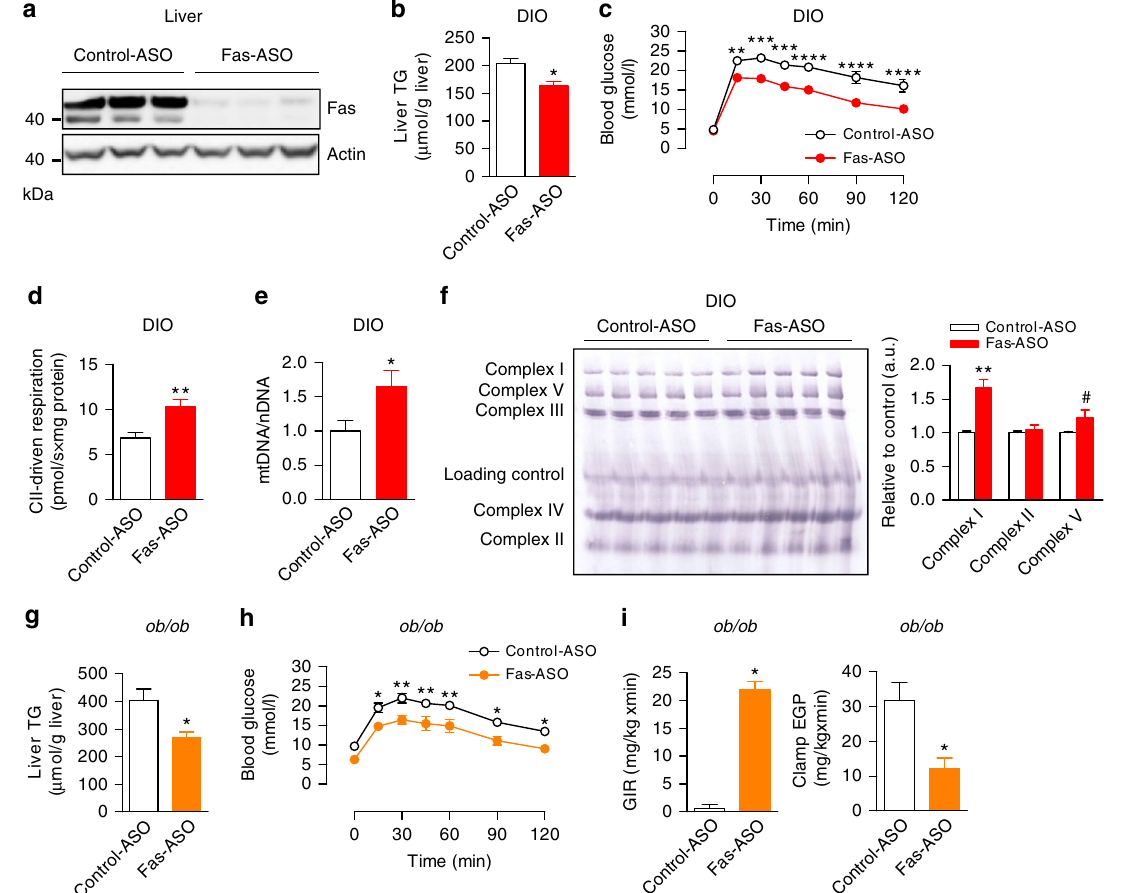
Fig. 5 Pharmacological depletion of Fas in obese mice ameliorates metabolic dysregulation and mitochondrial function. C57BL/6J mice on HFD for 20 weeks received either antisense oligonucleotides against Fas (Fas-ASO) or control-ASO once per week (50 mg/kg body weight) during the last 10 weeks of HFD. a Fas protein levels in total liver lysate of mice treated with control-ASO or Fas-ASO. b Liver TG levels (control-ASO, n = 5; Fas ASO, n = 4) and c intraperitoneal glucose tolerance test (2 g/kg body weight glucose; n = 5) in HFD-fed mice are shown. d Respirometry analysis of complex II (CII)-driven respiration in liver tissue of HFD-fed control-ASO and Fas-ASO mice (control-ASO n = 15, Fas ASO n = 16). e Mitochondrial DNA abundance in liver ( n = 6) and f blue native (BN) polyacrylamide gel electrophoresis (PAGE) of mitochondria isolated from liver ( n = 5) of HFD-fed control-ASO and Fas-ASO mice are presented. f – h Leptin-de fi cient ob/ob mice were injected with Fas-ASO or control-ASO (50 mg/kg body weight) twice per week for 4 weeks. g Liver TG levels ( n = 6), h intraperitoneal glucose tolerance test (1 g/kg body weight glucose) ( n = 6), i glucose infusion rate (GIR), and endogenous glucose production (EGP) during hyperinsulinemic-euglycemic clamps are depicted (control-ASO, n = 4; Fas ASO, n = 5). Values are expressed as mean ± s.e.m.; * p < 0.05, ** p < 0.01, *** p < 0.001, **** p < 0.0001, and # p = 0.09. Statistical tests used: t -test for ( b , d – g , i ( right panel )); Mann – Whitney for ( i ( left panel )); and ANOVA for ( c , h ). DIO diet-induced